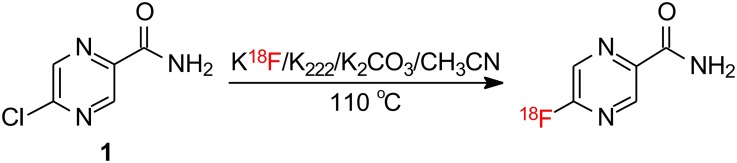
Radiosynthesis of 2-[18F]F-PZA.